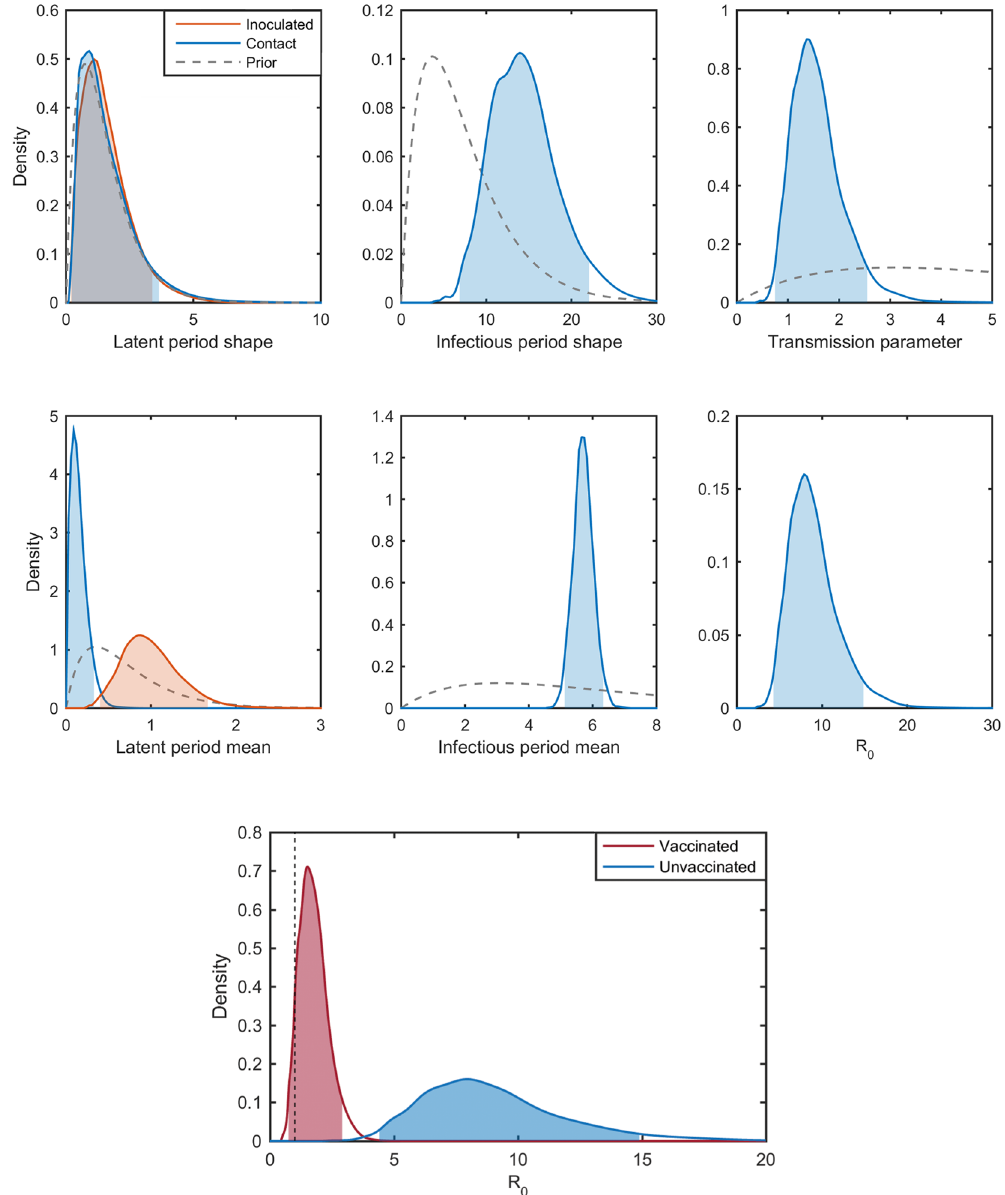
Figure 4. Epidemiological parameters for foot-and-mouth disease virus (FMDV) in pigs. Marginal posterior distributions for each parameters inferred from the FMDV transmission experiments between unvaccinated pigs (top panel). The latent period shape and mean posteriors are plotted in blue for in-contact pigs and in orange for inoculated. The shaded areas indicate the 95% highest posterior density intervals and priors are plotted as grey dashed lines. Posterior density plots of R 0 for vaccinated pigs in red and unvaccinated pigs in blue (bottom panel), with the shaded areas representing the 95% highest-posterior density interval. The dashed black line indicates the threshold value of R 0 =